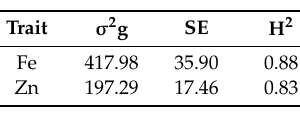
Table 3. Genotypic variance ( σ 2g), standard error (SE), and operational heritability (H 2 , broad-sense) for the traits observed in the (ICMS 8511-deriv × AIMP 92901-deriv-08)-derived RIL population at